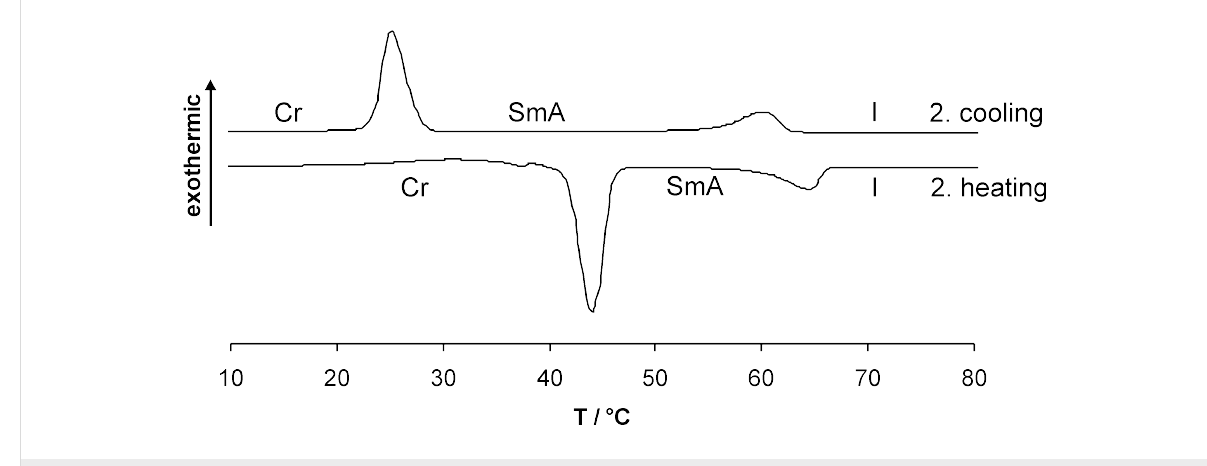
Figure 5: DSC curve of compound 6c (heating/cooling rate 10 K/min).